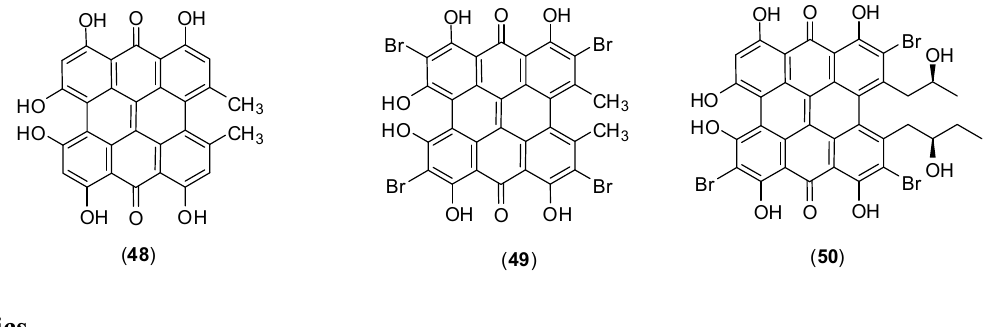
Figure 20. Structures of polycyclic quinones 48 , 49 and 50